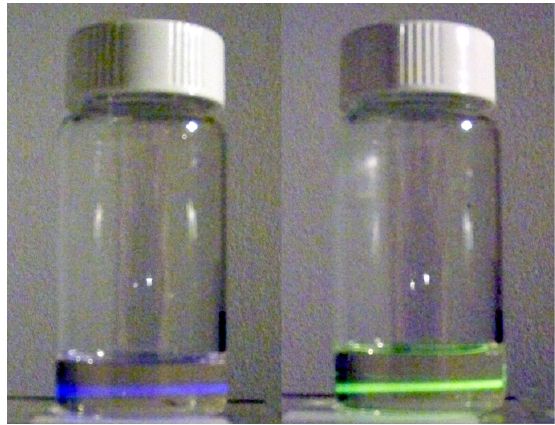
Fig. 1. NaYF 4 nanocrystals codoped with Yb 3 þ and Tm 3 þ (left) or Er 3 þ (right). UCNPs shown here were synthesized by thermal decomposition of LnTFA precursors, and had an average diameter of (cid:1) 15 nm. Illumination was by laser diode at 980